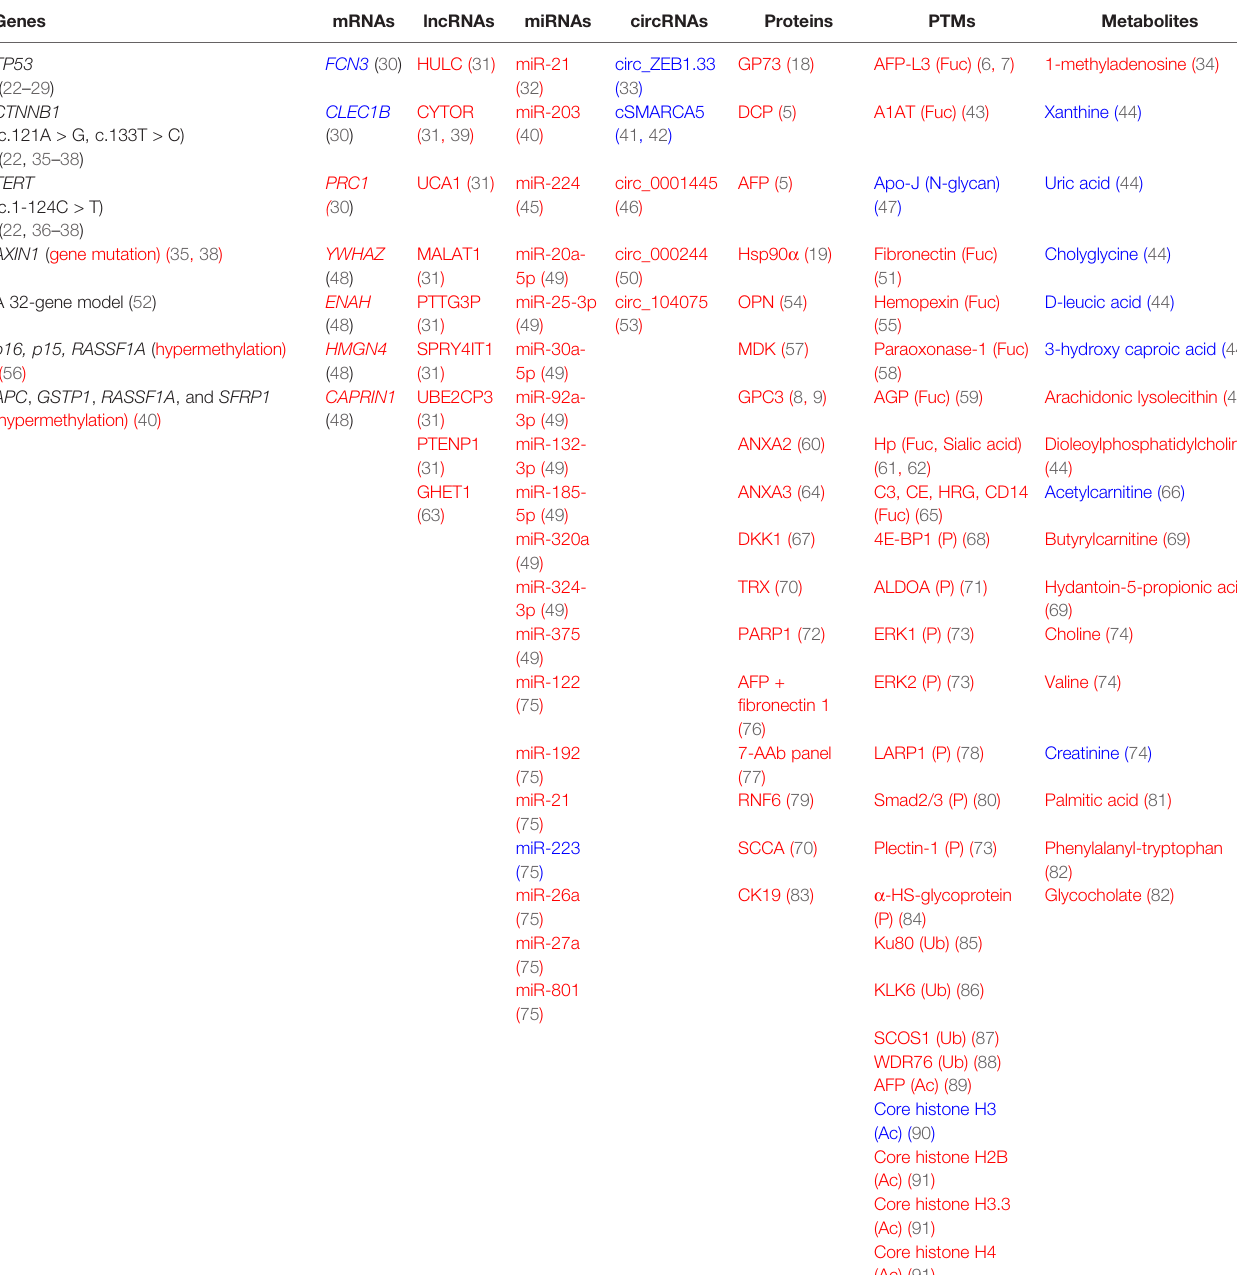
TABLE 1 | Potential biomarkers for HCC based on multi-omics